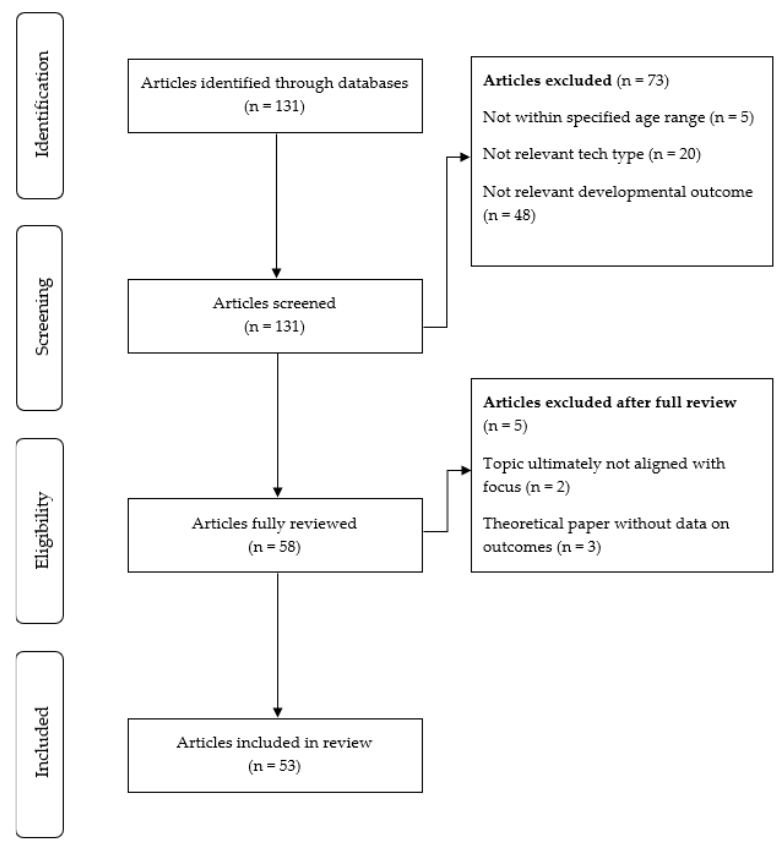
Figure 2. PRISMA Flow Diagram for Scoping Review.